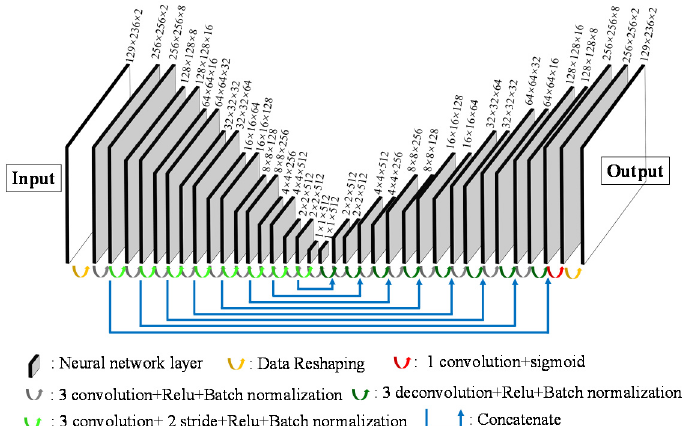
Figure 1. The neural network structure of the proposed convolutional neural network (CNN)-denoiser. Inputs are the real and imaginary parts of time–frequency coe ffi cients of the noisy signal. The gray rectangles represent the neural network layers. Arrows represent di ff erent operations applied between two adjacent layers. Batch normalization and concatenate are used to improve convergence during training. The dimension of each layer presented above indicates “frequency bins × time points × filters”. Outputs are two masks for the estimation of the time–frequency coe ffi cients of the microseismic signal and noise.